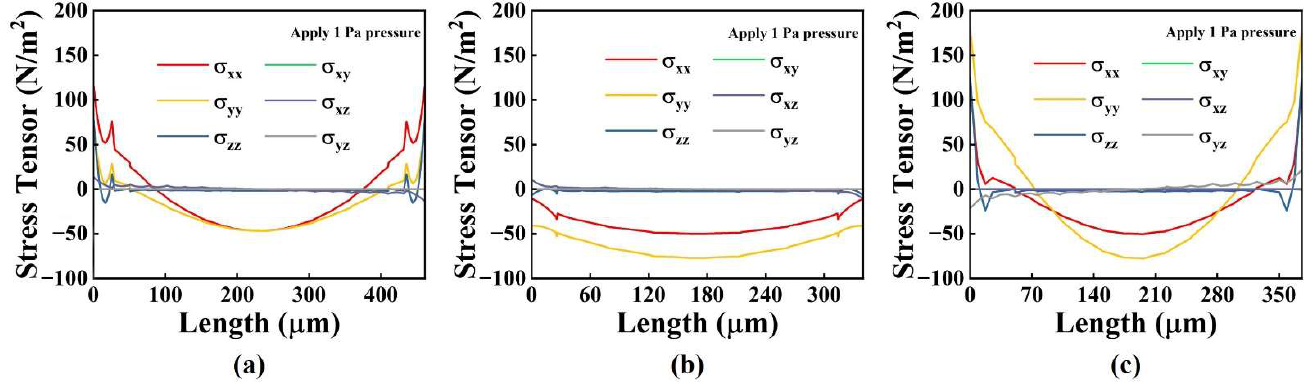
Figure 2. The stress distribution of ( a ) square diaphragm; ( b ) length direction of I-shaped diaphragm; ( c ) width direction of I-shaped diaphragm.